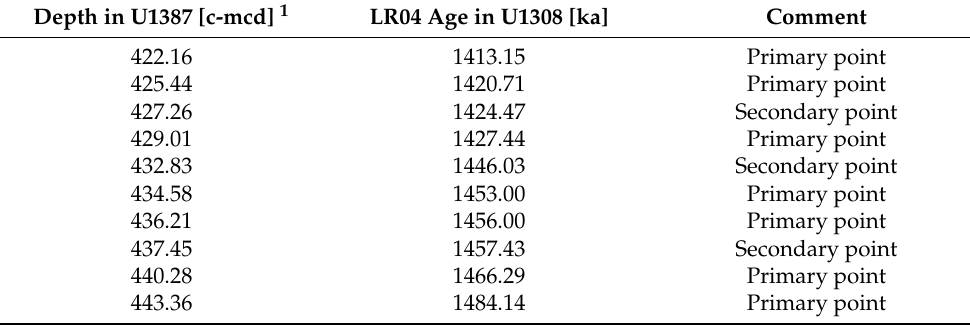
Table 1. Age model tuning points for IODP Site